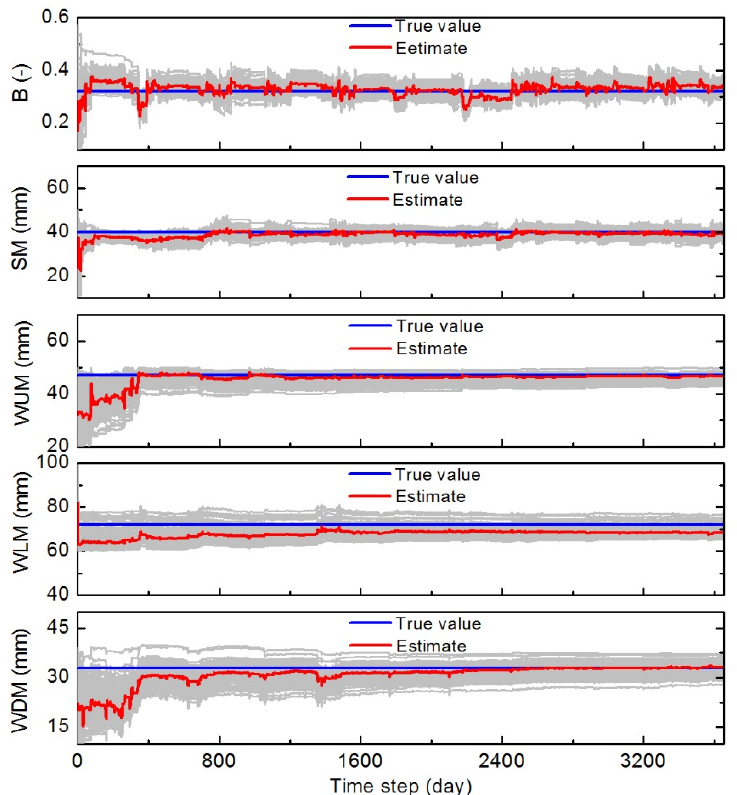
Figure 1. Parameter estimations under the stationary condition with the Low_Level uncertainty as shown in Table 2 (The grey lines represent the ensemble members).